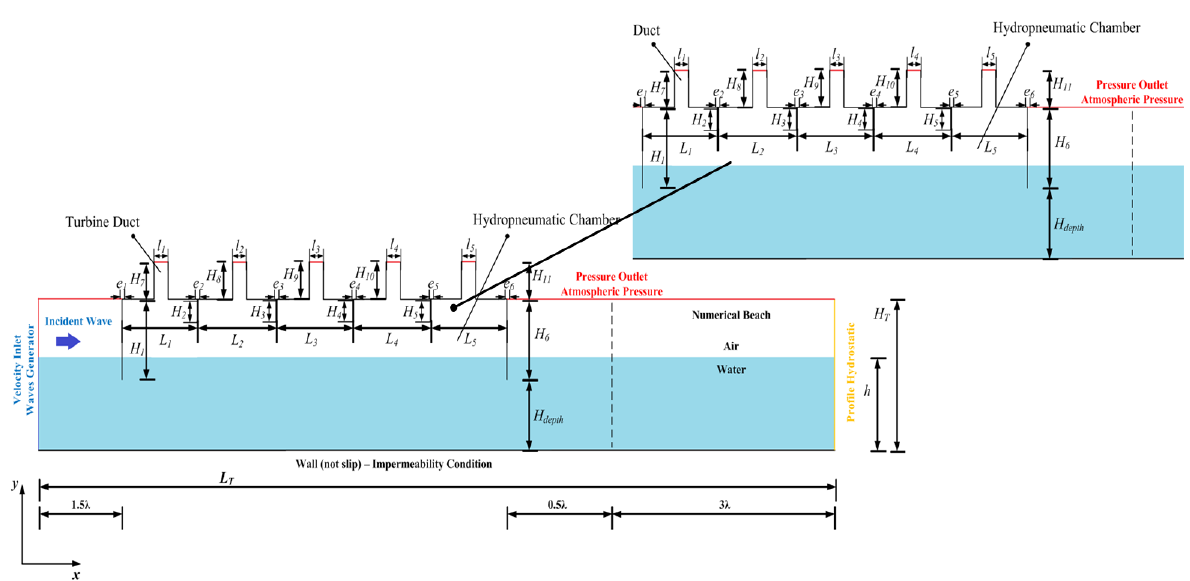
Figure 4. Details and characteristics of the OWC device.